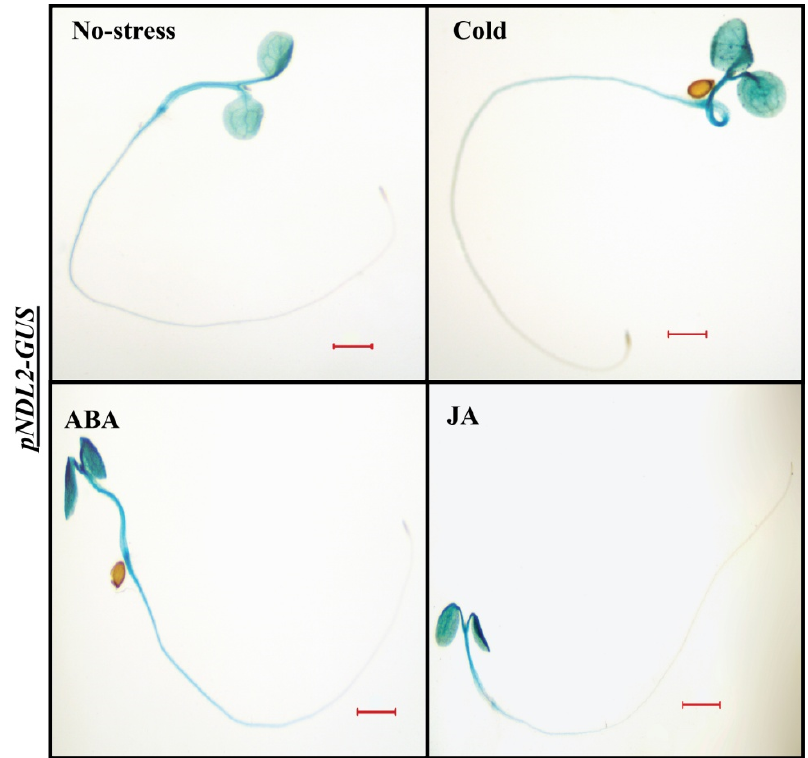
Figure 6. In vivo histochemical analysis of GUS activity for NDL2 in wild type Col-0 background in response to different abiotic stresses and hormones: Histochemical GUS staining of 6-D-old transgenic Arabidopsis seedlings ( pNDL2-GUS) in wild type Col-0 background. Increased intensity levels of GUS staining detected with ABA, cold, and JA. Result shown is representative of three independent biological replicates ( n ≥ 10 in each experiment). Scale Bar = 0.2 μM.